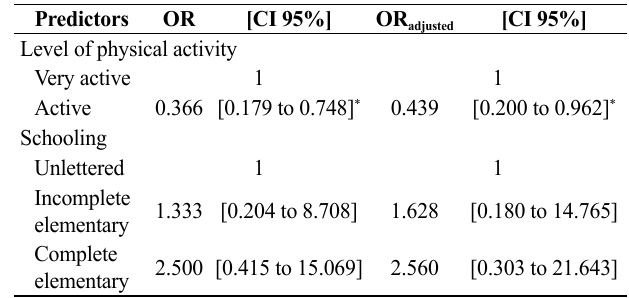
Table 2. Comparison of the proportions of elderly practitioners and non-practitioners of systematized physical exercises according to level of physical activity and perception of the memory.